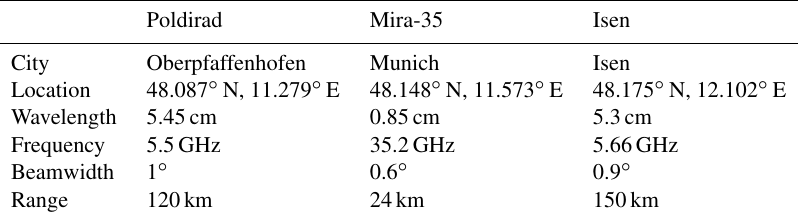
Table 1. Radar characteristics. For the Isen radar, the precipitation scan at 1.5 ◦ elevation was referenced. For the full configuration of the volume scan, see Helmert et al.